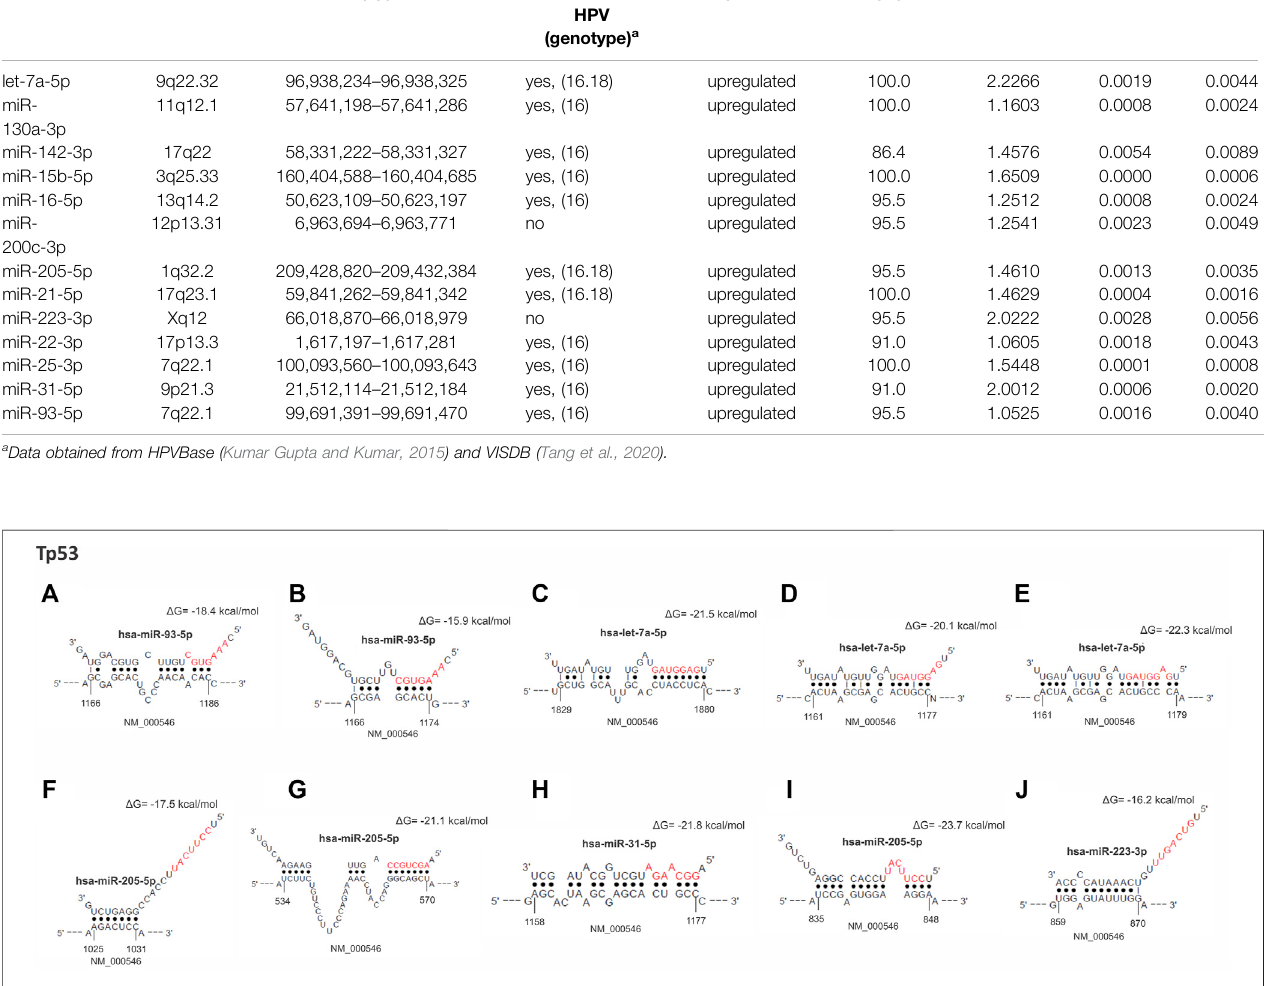
Figure 1 Relative expression of thirteen miRNAs upregulated (tumor vs. non-tumor) in the PeCa studied.